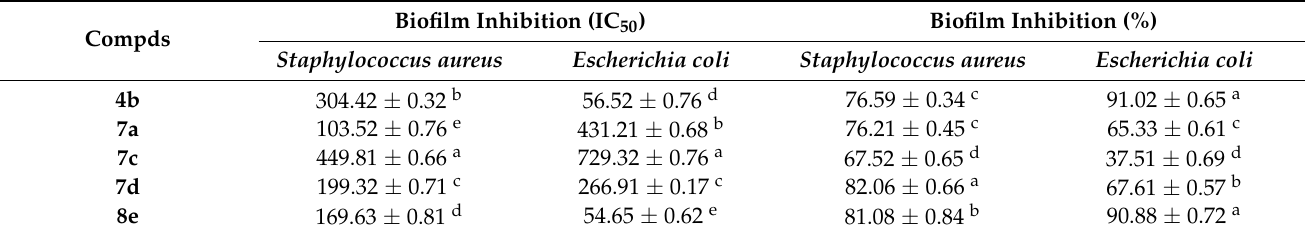
Table 3. Biofilm inhibition (%) and (IC 50 ) from Staphylococcus aureus and Escherichia coli cultures treated with the most active selected compounds.